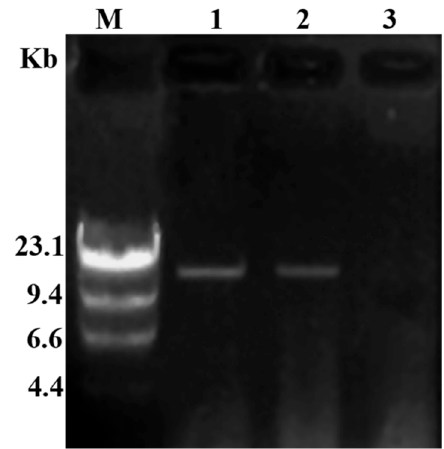
Figure 4. Detection of dsRNAs in viral donor and recipient strains of Rhizoctonai solani AG-1 IA. M: molecular markers ( λ DNA digested with Hind III); 1: The presence of dsRNA in derivative isogenic strain GD-118P-V1; 2: The presence of dsRNA in virus-containing donor strain GD-2; 3: The absence of dsRNA in virus-free recipient strain GD-118P.